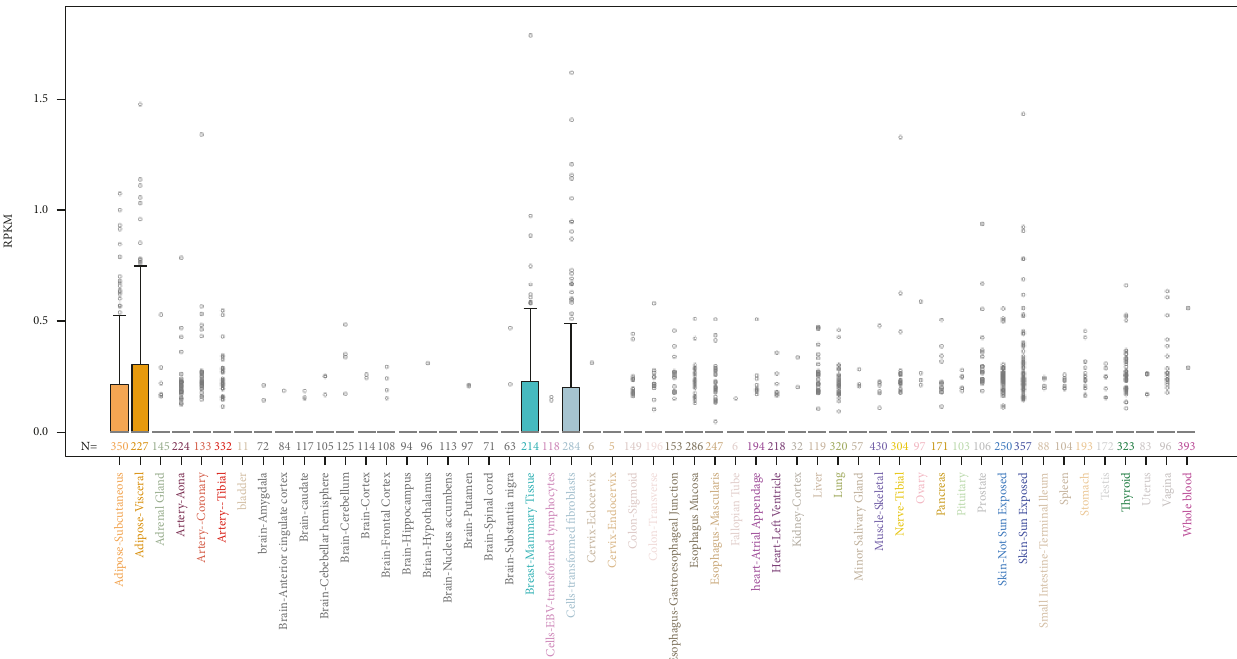
Figure 2: Expression pro fi le of miR-193a in normal tissues. The expression level of miR-193a is reported for 51 tissues and 2 cell lines (EBV-transformed lymphocytes and transformed fi broblasts) and is referred to GTEx project collected in Genome Browser. Expression values are shown in RPKM (reads per kilobase of transcript per million mapped reads). The height of each bar represents the median expression level across all samples for a tissue, and points are outliers if they are above or below 1.5 times the interquartile range. Each color represents a speci fi c tissue, conformed to GTEX consortium publication